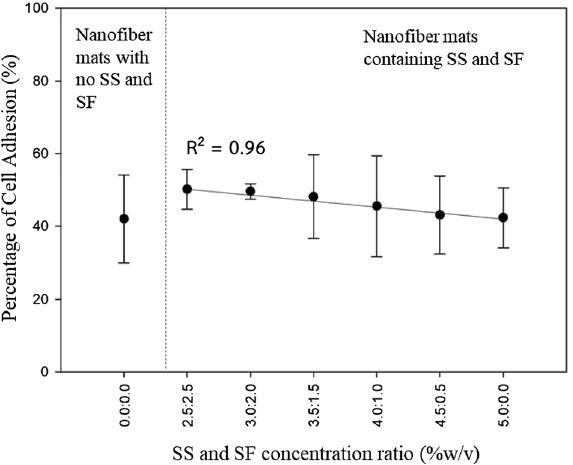
Figure 5. Cell adhesion on the fabricated nanofiber mats with different SS/SF concentration